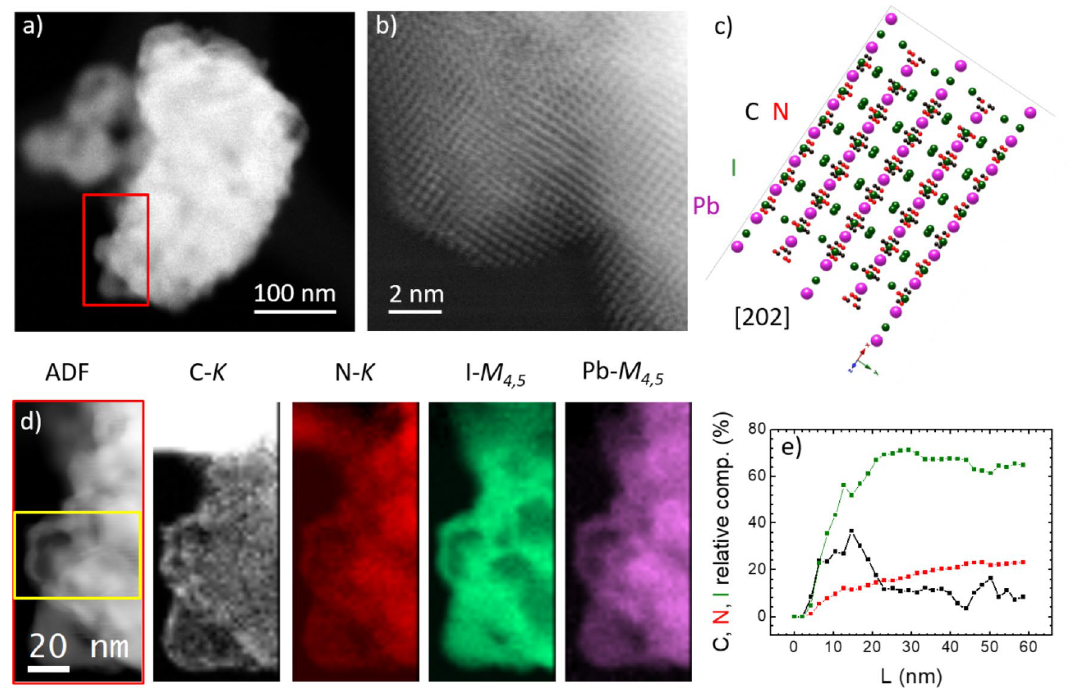
Figure 6. ( a ) HAADF image of one MAPbI 3 grain. Red rectangle indicates the region where EELS data are taken. ( b ) High resolution HAADF image of a part of the grain. ( c ) Crystal in [202] zone axis based on the model taken from neutron characterization. ( d ) EELS analysis: simultaneous annular dark field image and carbon, nitrogen, iodine and lead elemental maps. ( e ) Profile in horizontal direction of chemical composition taken from the area of yellow rectangle in ( d